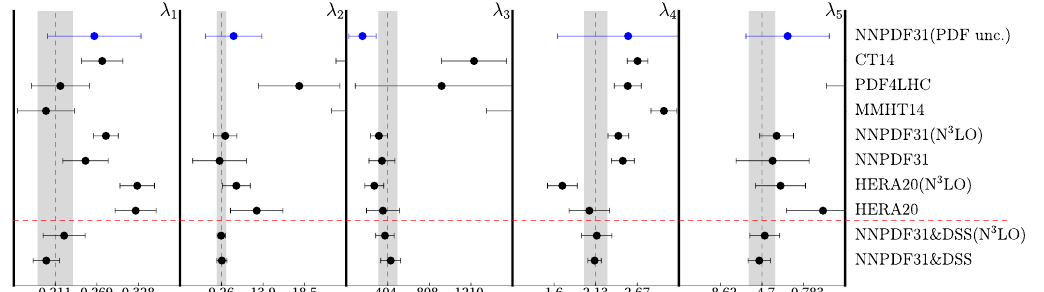
Figure 7 . Comparison of NP parameter for unpolarized TMDPDF extracted in di(cid:11)erent (cid:12)ts. The values above the red-dashed line are extracted in (cid:12)t of DY data, see table 5. The values below the red-dashed line are extracted in global (cid:12)t of DY and SIDIS data, see table 9. The vertical dashed lines and gray boxes correspond to average mean and standard deviation of the results of the global (cid:12)t. The blue points and their error-bars correspond to the estimation of the uncertainties from the collinear PDF (see section 5.3). The input collinear distributions are marked in the right column. For CT14 and MMHT14 some NP parameters are beyond the plot